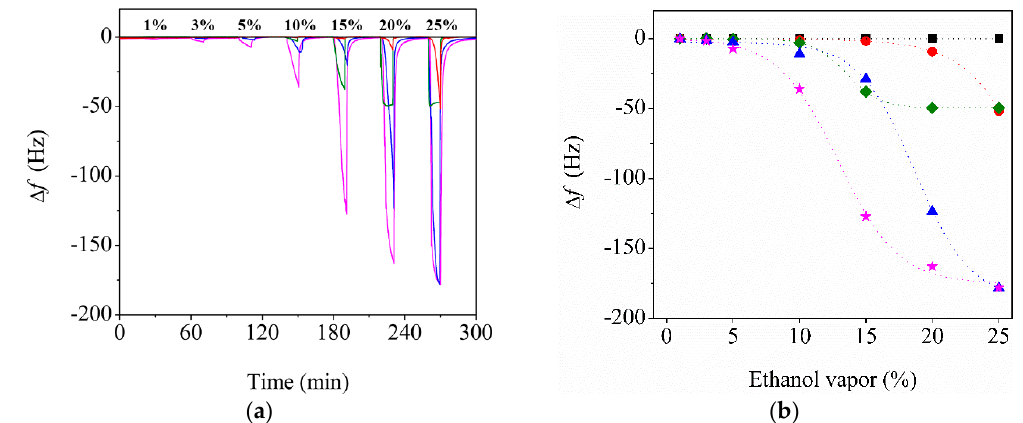
Figure 5. ( a ) Time-dependent changes in the resonance frequency changes of the bare QTF (black), P30-QTF (red), P60-QTF (green), CP30-QTF (blue), and CP60-QTF (pink) upon exposure to ethanol vapor. The concentrations of ethanol vapor were varied sequentially at each of the following measurements: 1%, 3%, 5%, 10%, 15%, 20%, and 25%. ( b ) Changes in the resonance frequencies of the bare QTF (black square), P30-QTF (red circle), P60-QTF (green diamond), CP30-QTF (blue triangle), and CP60-QTF (pink star) upon exposure to ethanol vapor. Dashed curves were made to guide the eye.